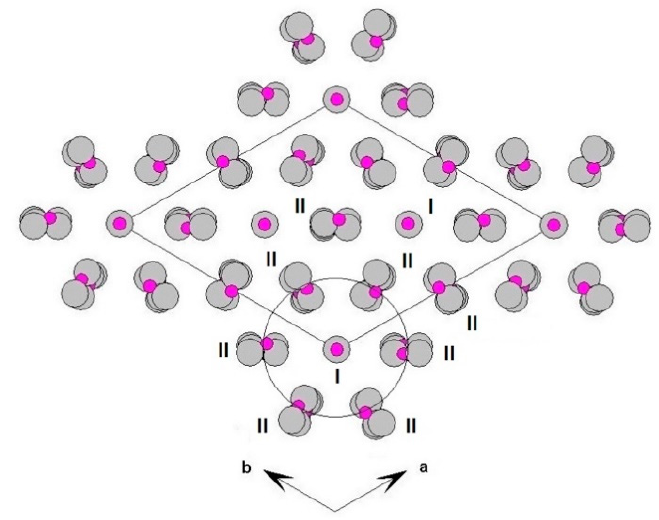
Figure 5. Three-dimensional framework of whitlockite. Detail of the I and II columnar arrays, viewed down c.